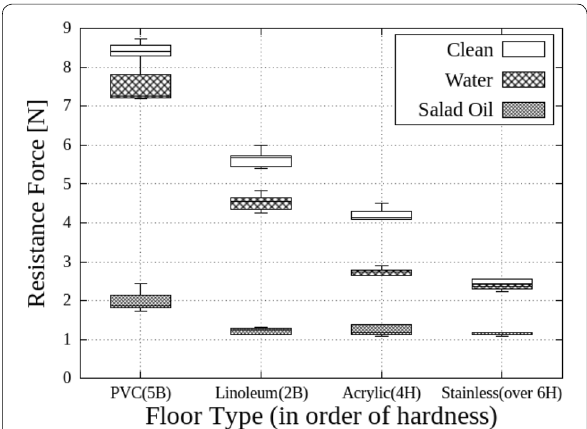
Fig. 11 Average resistance force and pencil